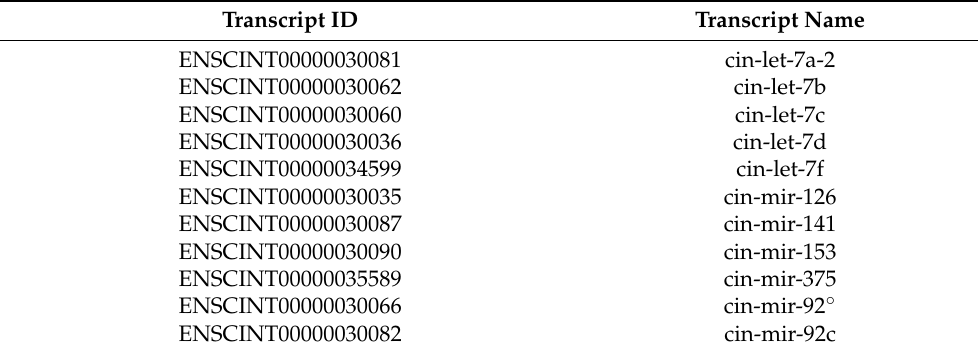
Table 1. MicroRNAs (miRNAs) conserved.